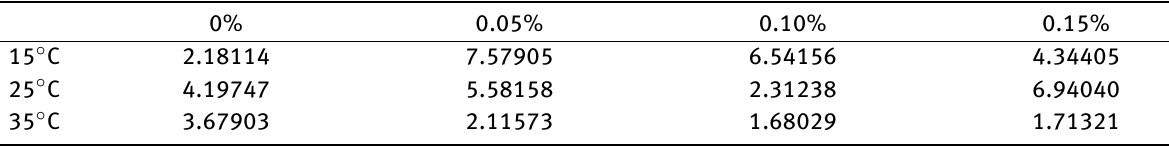
Table 9: The probability deviation of ZSV corresponding to the test results is shown Table 8 ( × 10 4 Pa · s,